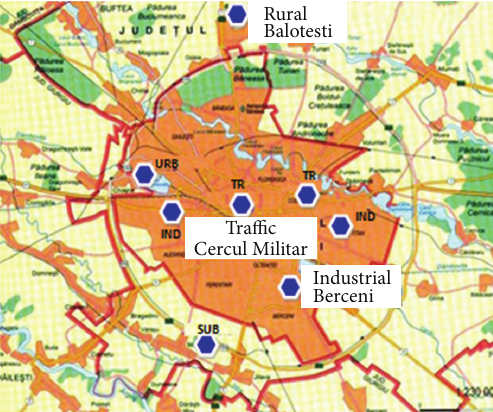
Figure 2: Locations of in situ monitoring stations in